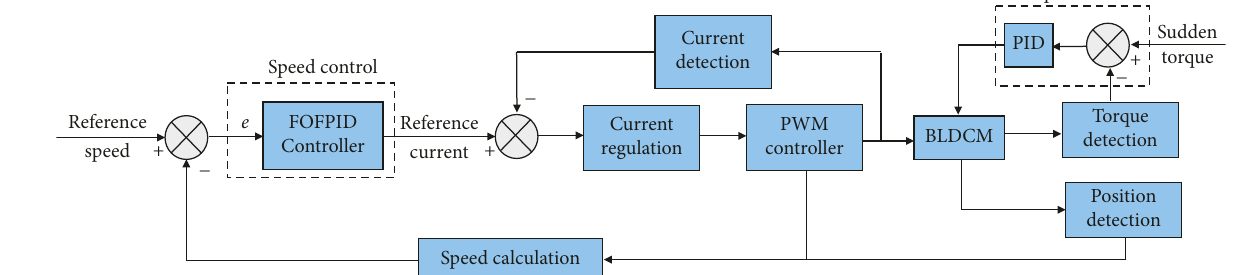
Figure 1: Modular modelling schematic of the BLDCM system.